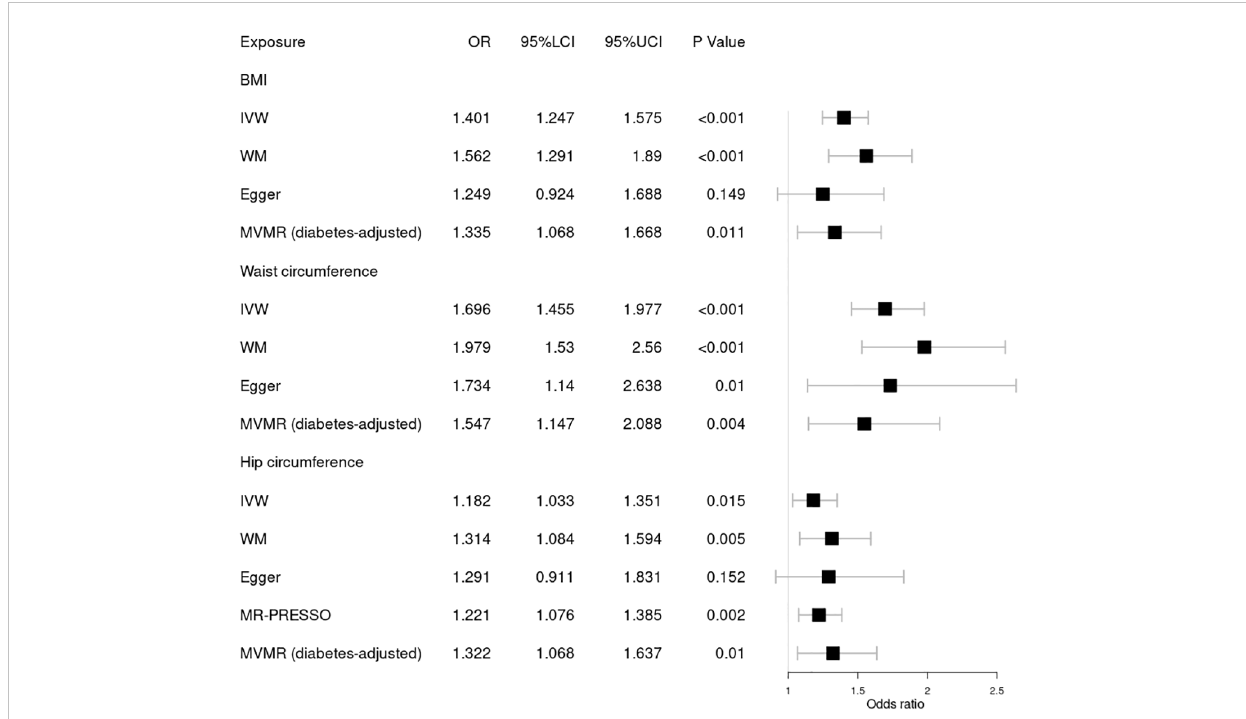
FIGURE 4 Forest plot of Mendelian randomization results of obesity effect on proliferative DR. BMI, body mass index; IVW, inverse variance weighted; Egger, MR – Egger; WM, weighted-median; MR-PRESSO, the outlier-corrected MR pleiotropy residual sum and outlier results (two signi fi cant outliers, SNV: rs35506085; SNV:rs7903146); MVMR, multivariable Mendelian randomization; 95% LCI, lower limit of 95% CI; 95% UCI, upper limit of 95%